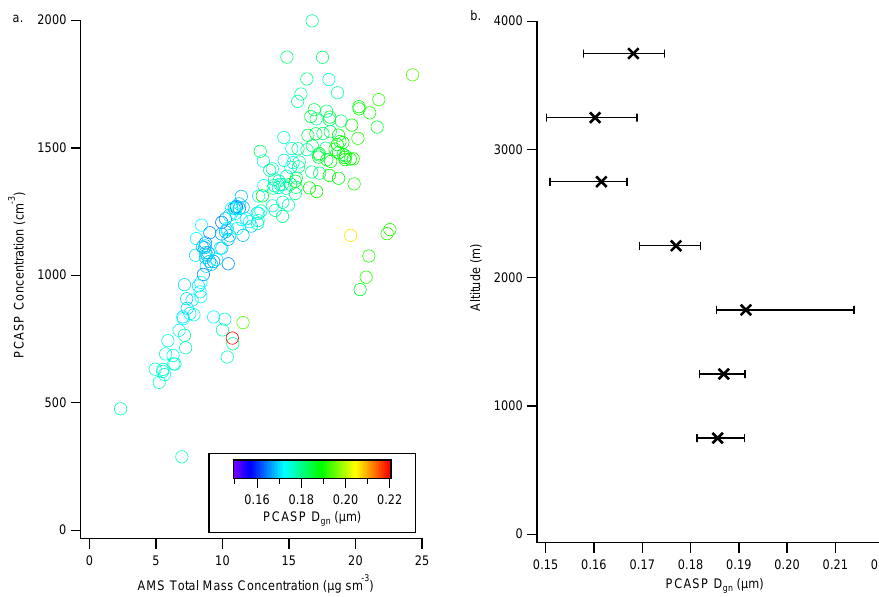
Fig. 7. Relationship between aerosol microphysical properties and total mass concentration from the AMS. Panel (a) displays the relationship between the sub-micron aerosol number concentration from the PCASP instrument with total AMS mass concentration. The points are coloured according to the sub-micron geometric mean diameter. Panel (b) shows the sub-micron geometric mean diameter derived from the PCASP measurements as a function of height when averaged over SLRs. The crosses refer to the median geometric diameter, while the horizontal bars represent the 25th and 75th